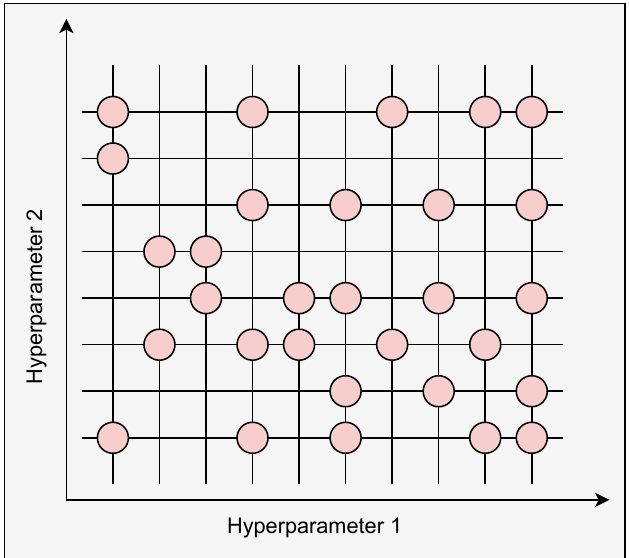
Figure 8. Random Search sample plotting for two